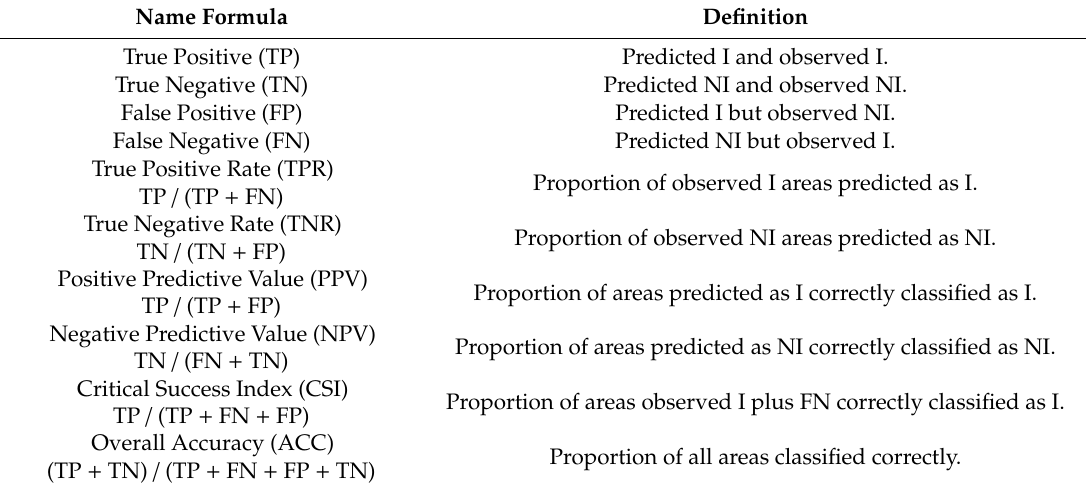
Table 2. Summary of primary and secondary binary classification metrics